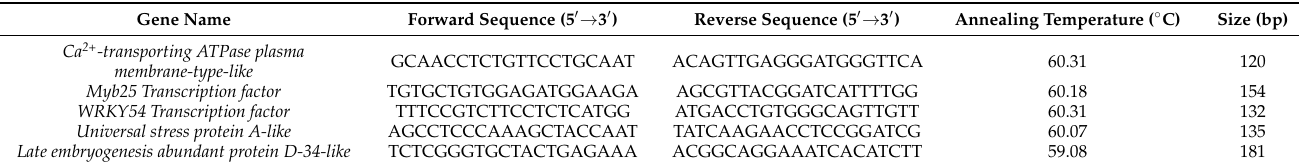
Table 1. Primer sequence list used in the RT-qPCR